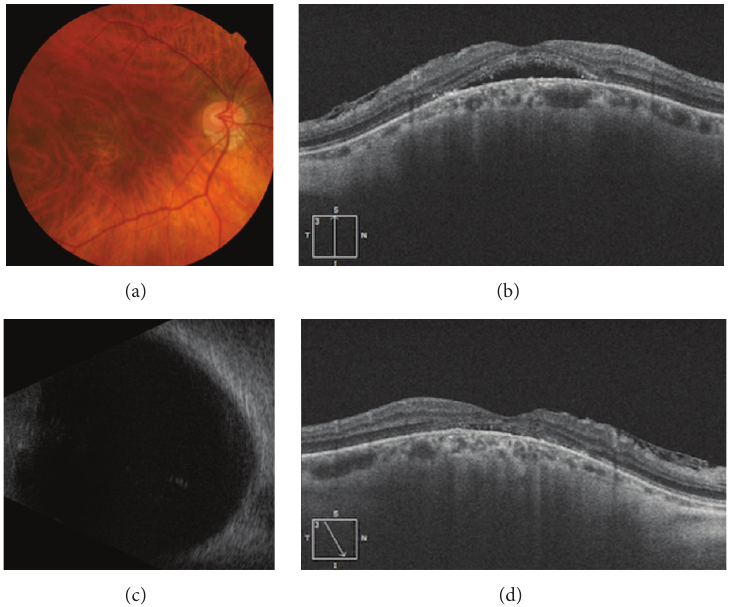
Figure 2: Staphyloma edge with serous retinal detachment before and after treatment with spironolactone. (a) Color photo showing a tilted- disc with a type 5 staphyloma described by Curtin [2], inferior peripapillary atrophy, marked retinal thinning with visible choroidal vessel, but no hemorrhage in the foveal area. (b) Pretreatment OCT image showing serous retinal detachment in the foveal area with associated epiretinal membrane. (c) B-scan ultrasound showing an abnormal ocular wall in the posterior fundus. (d) Posttreatment OCT image showing resolution of the serous retinal detachment in the foveal area with an abnormal ellipsoid line and associated epiretinal